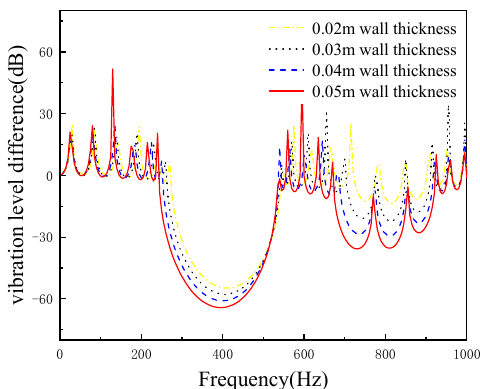
Figure 7. The effect of the wall thickness on the cushioning performance.